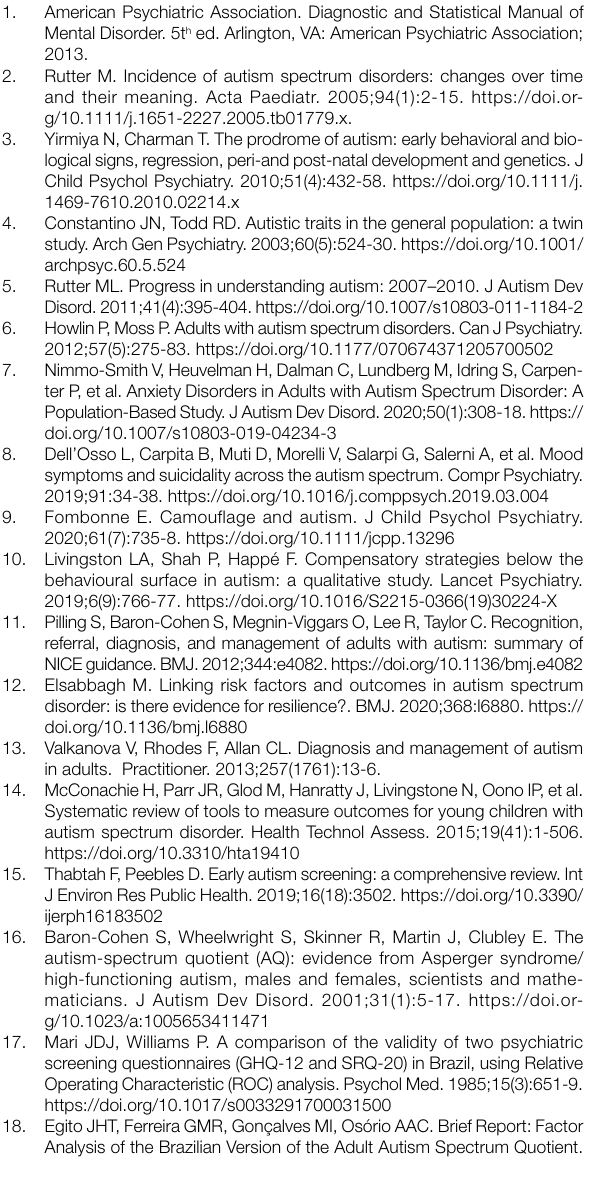
Normative data and performance analyses of the Autism Spectrum Quotient in a sample of